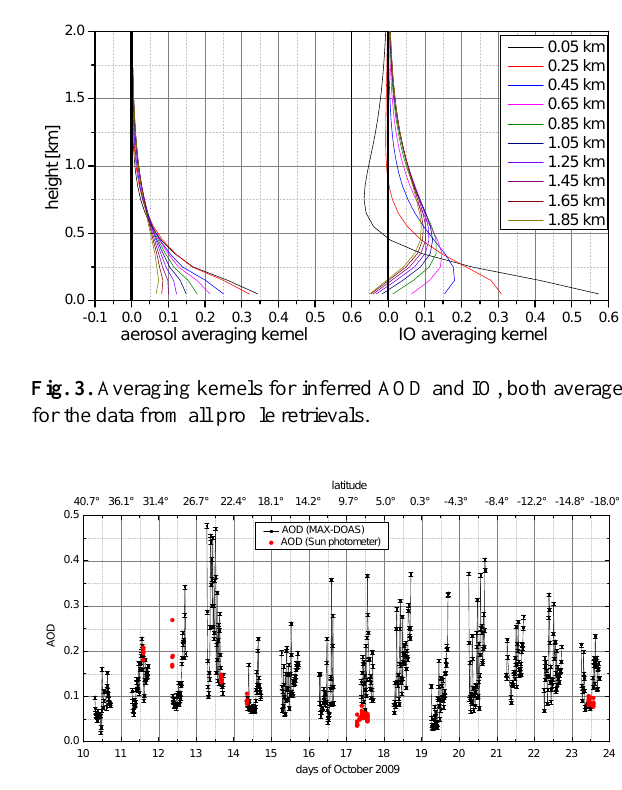
Fig. 3: Averaging kernels for inferred AOD and IO , both averaged for the data from all profile retrievals.